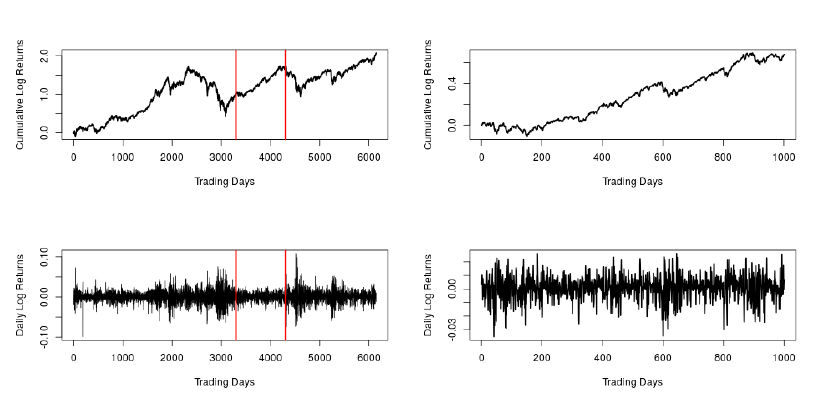
Figure 6. Cumulative and daily log-returns of the DAX index between 26/11/1990 and 05/03/2015 (left panel) 16/4/1998 and 4/02/2002 (right panel). The vertical lines on the left panel correspond to the time period on the right panel, downloaded from